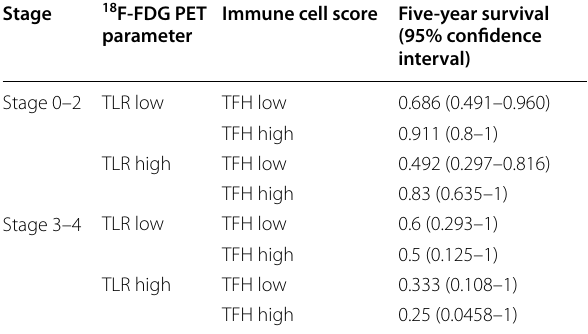
TLR low/TLR high: categorical groups divided by the median value of the tumor- to-liver SUVmax ratio, TFH low/TFH high: categorical groups divided by the median value of the follicular helper T cell score